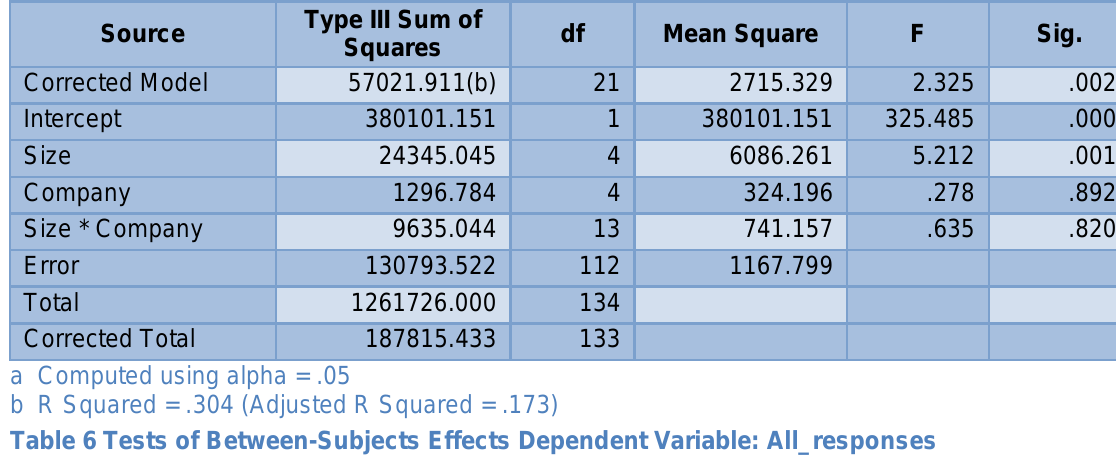
Table 6 Tests of Between-Subjects Effects Dependent Variable: All_responses